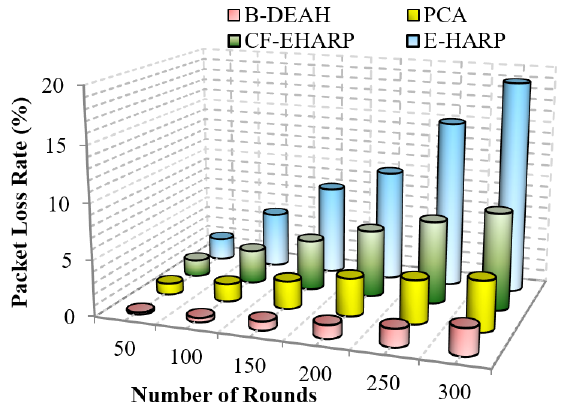
Figure 12. Packet loss rate vs. simulation rounds.